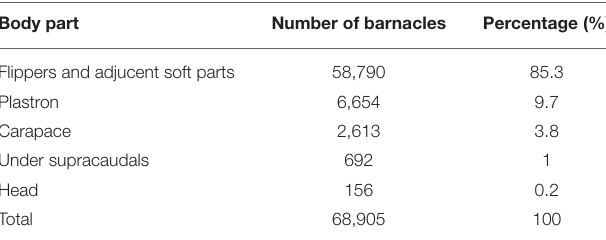
TABLE 4 | Occurrence of barnacles on different body parts of the hawksbill sea turtles nesting on Shibderaz (Qeshm Island) and Dayyer-Nakhiloo National Park (DNNP) in the Persian